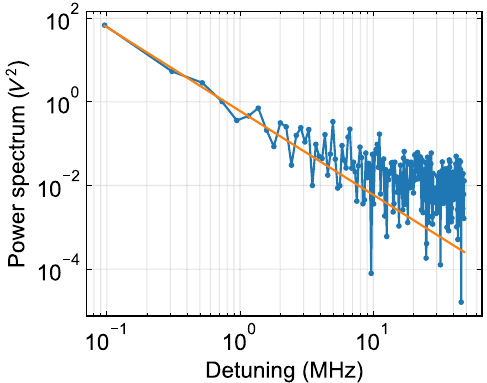
FIG. 10. Ramsey oscillation experiment. The horizontal axis represents the detuning from the qubit eigenfrequency, and the vertical axis represents the power spectrum of the Ramsey oscil- lation. The points connected by the blue line represent the experimental data, and the orange line represents the fitting